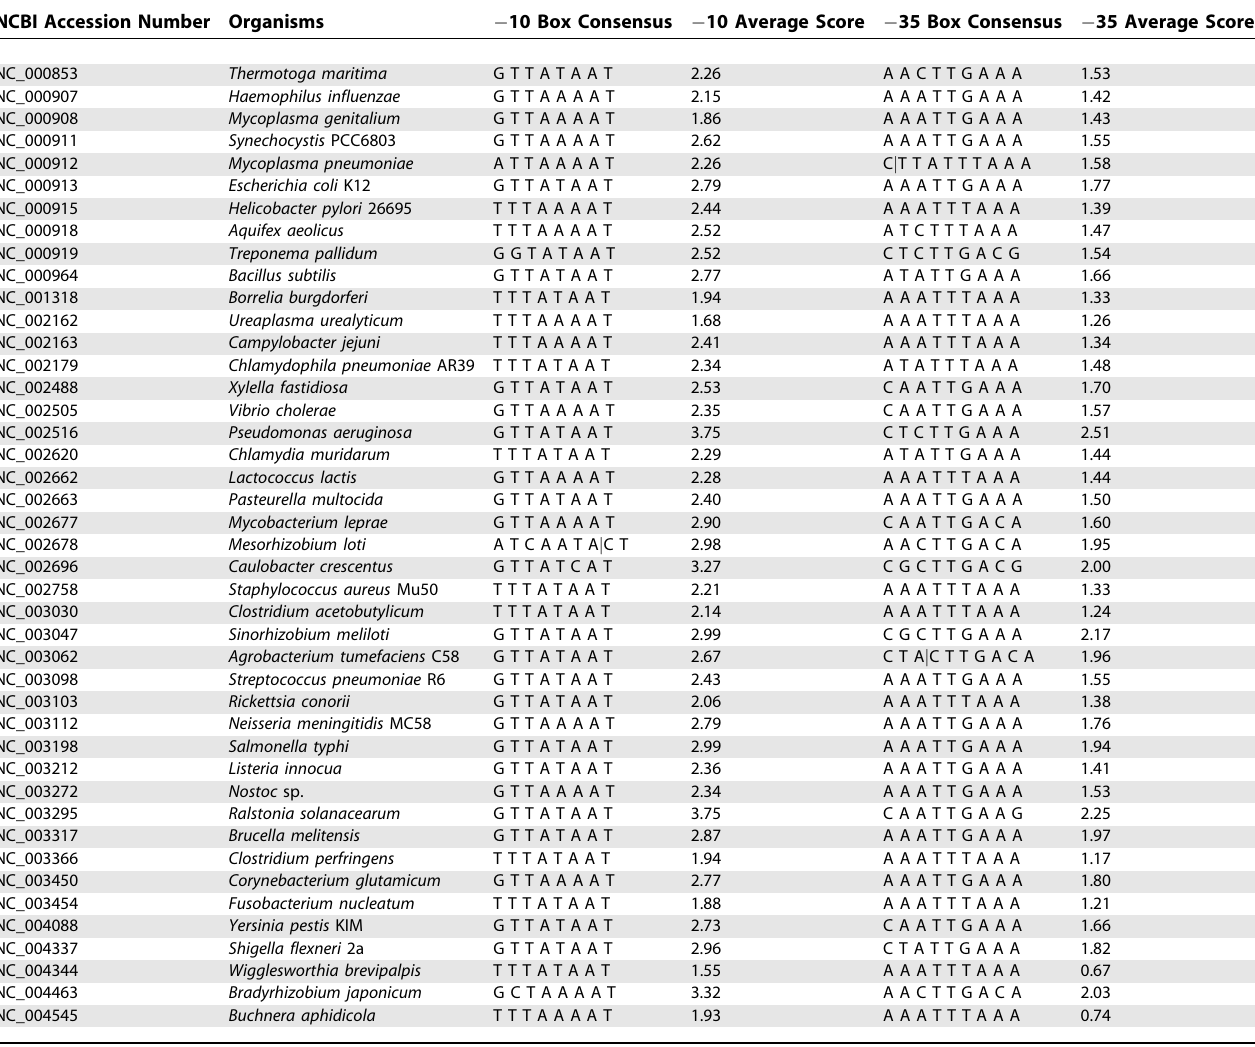
Table 1. (cid:1) 10 and (cid:1) 35 Consensi and Corresponding Average Scores for r 70 Promoter-Like Signals in Representative Bacterial Genomes NCBI Accession Number